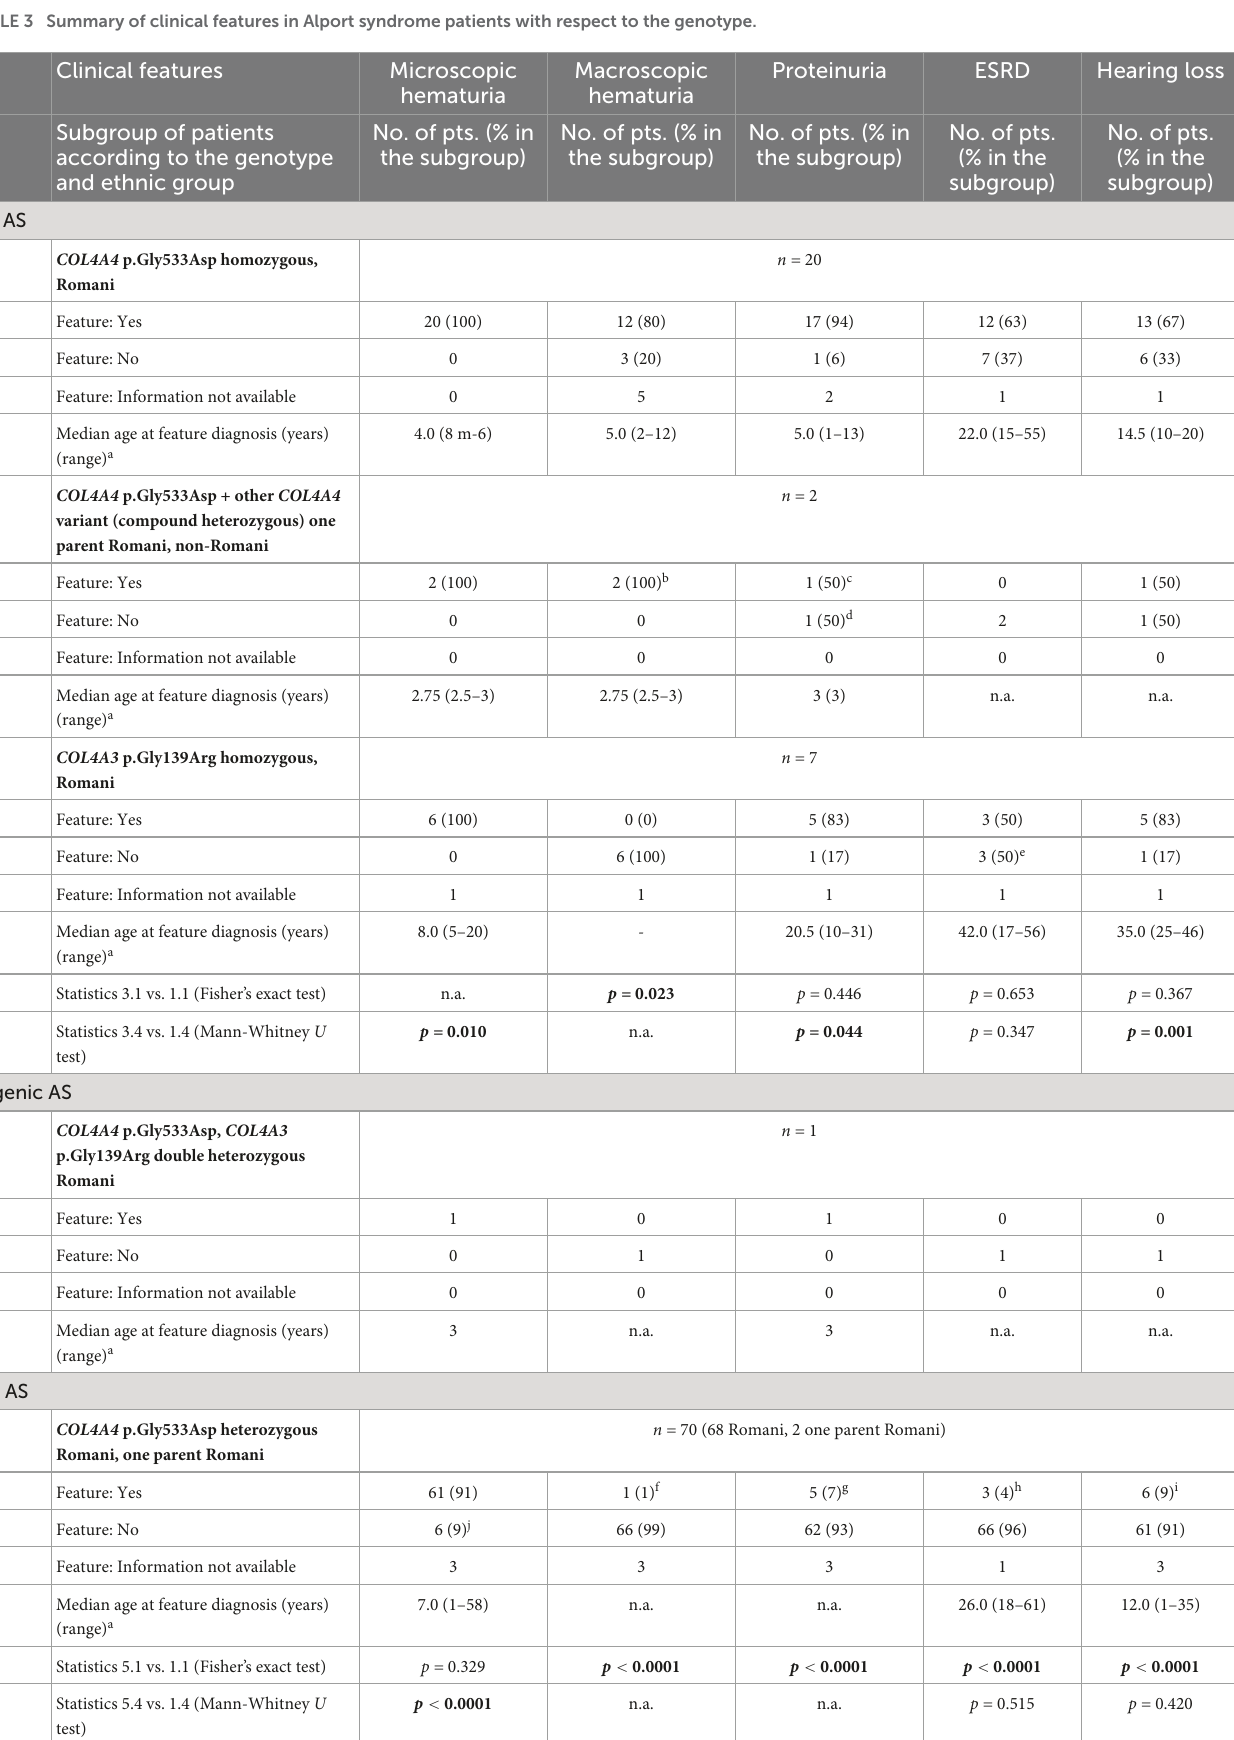
TABLE 3 Summary of clinical features in Alport syndrome patients with respect to the genotype. Clinical